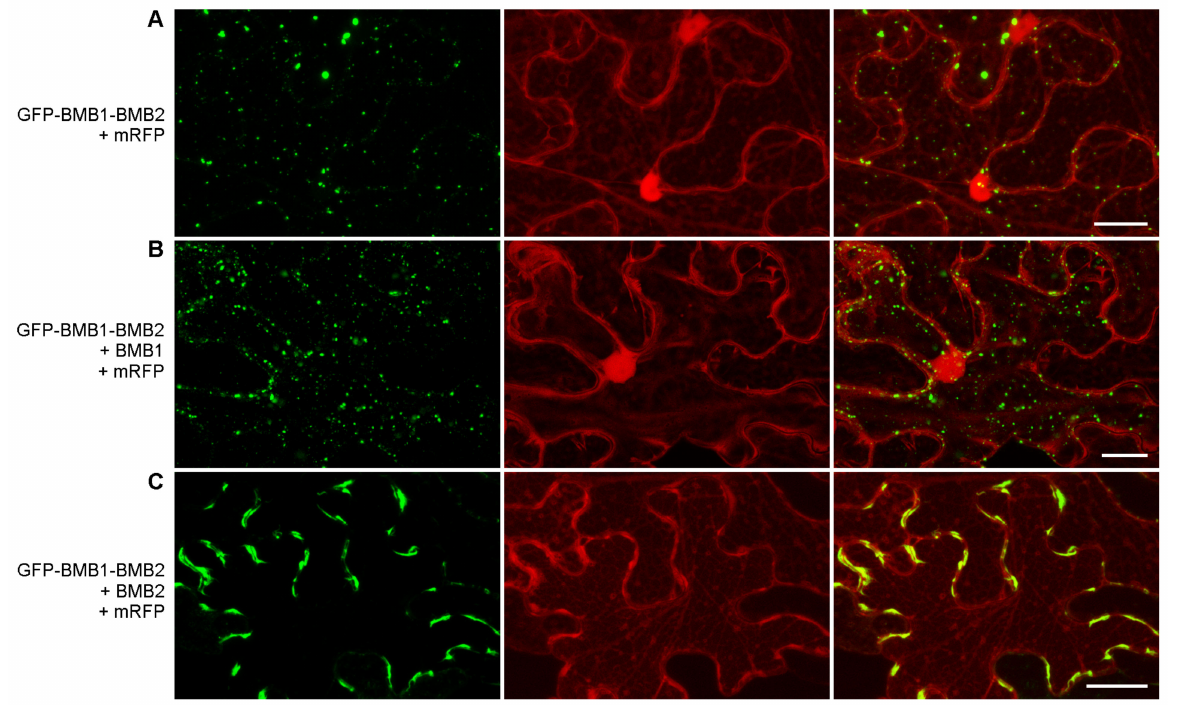
Figure 10. Subcellular localization of the BMB1-BMB2 fusion protein. GFP-BMB1-BMB2 was coex- pressed with mRFP used to visualize the cell shape and the nuclei ( A ), or with mRFP and either BMB1 ( B ) or BMB2 ( C ). Left images, GFP channel. Center images, mRFP channel. Right images, superposition of images for GFP and mRFP channels. Scale bar, 20 µ